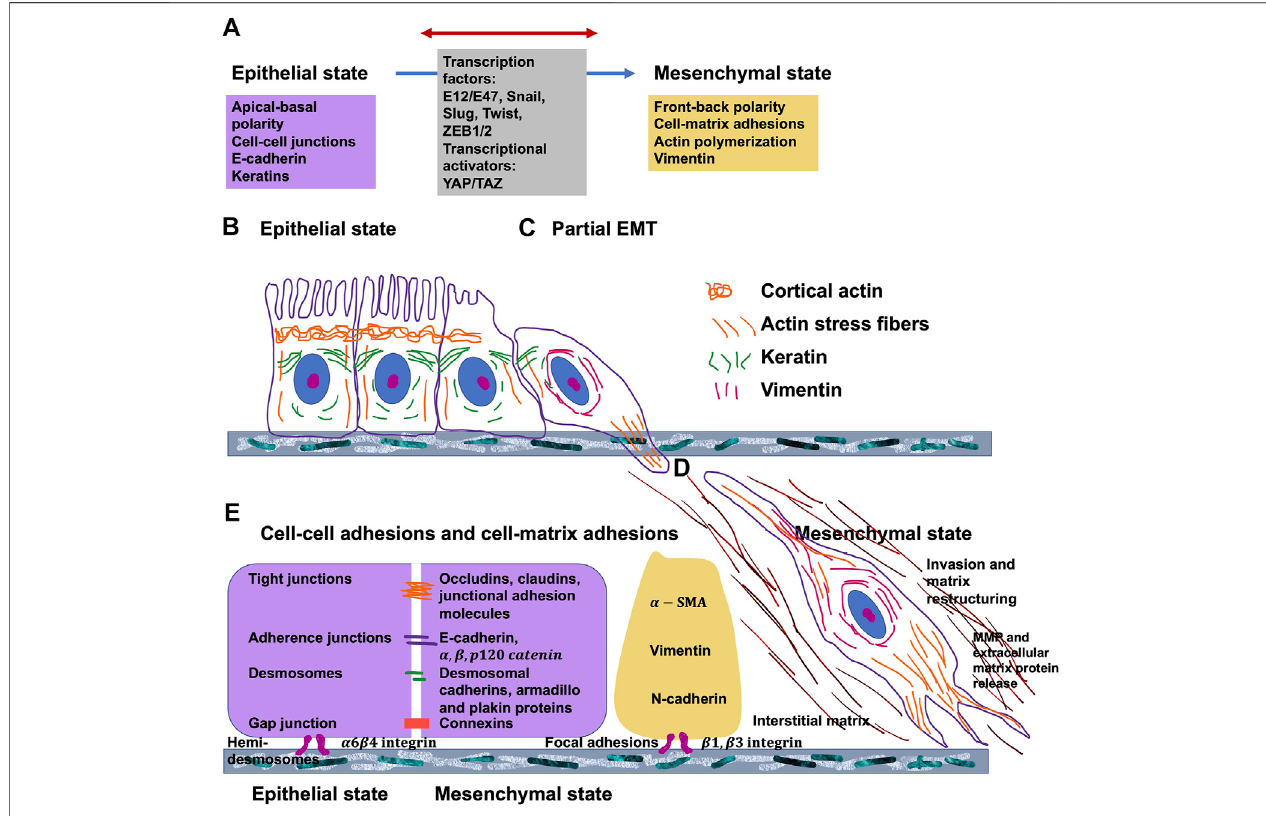
FIGURE 9 | Epithelial-to-mesenchymal (EMT) progression. (A) General characteristics of epithelial and mesenchymal phenotypes and transcription factors that govern EMT. Cell shape and cytoskeletal structure of (B) epithelial stage, (C) partial EMT stage and (D) mesenchymal stage. (E) Cell-cell and cell matrix adhesions.